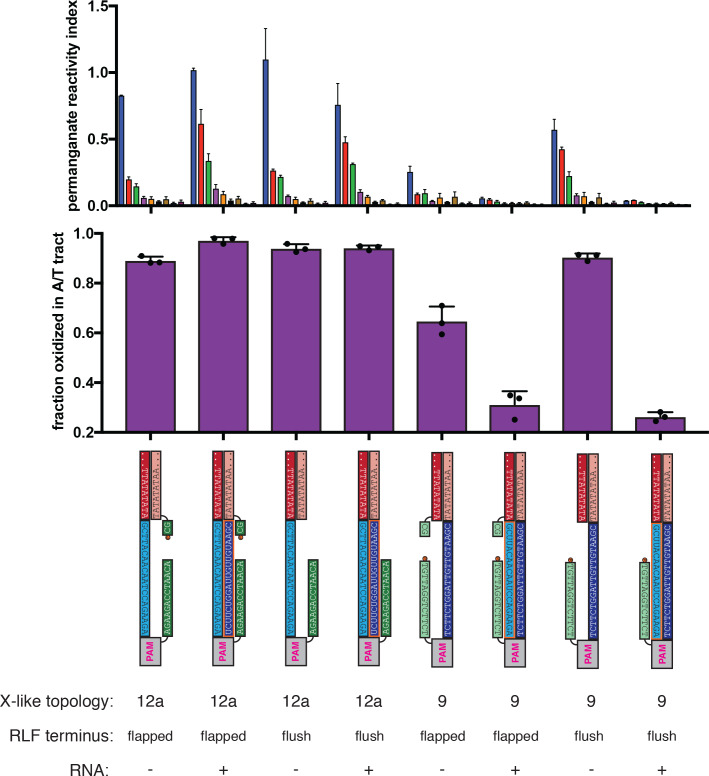
Effect of overhanging non-target-strand nucleotides on permanganate reactivity of the A/T tract in protein-free R-loops.Permanganate experiments were conducted as in Figure 2B (2 minutes, 30°C). See Materials and methods for description of the parameters plotted on the y-axis. Columns and associated error bars indicate the mean and standard deviation of three replicates. In all schematics, RNA molecules are outlined in orange, and DNA molecules are outlined in black. Circled ‘P’ indicates a 5′-phosphate. All sequences, when read right-side up, go from 5′ on the left to 3′ on the right. These experiments probe the role of the 2-nt NTS overhang (immediately adjacent to the R-loop flank) in distortion of the A/T tract. When present, this dinucleotide results in a ‘flapped’ R-loop flank (RLF) terminus, and when absent, the RLF terminus is ‘flush.’ The terms ‘(Cas)12a-like’ and ‘(Cas)9-like’ are descriptors only of each substrate’s R-loop topology (the end of the RNA next to the boundary of interest is a 3′ end or a 5′ end, respectively)—both kinds of substrates contain a Cas12a PAM and a Cas12a-like NTS gap. These results show that the presence of the overhang can affect the absolute magnitude of distortion, but the nature of the asymmetry is unaffected.